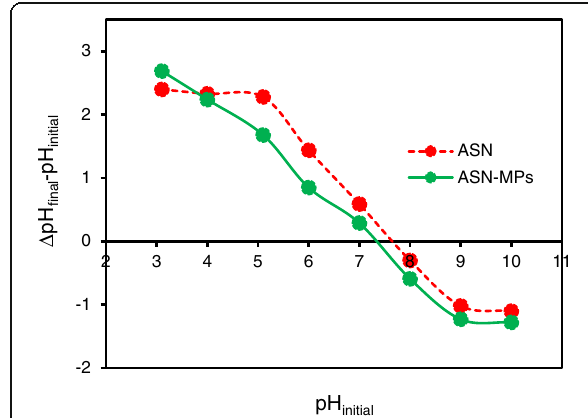
Fig. 5 Determination of the point of zero charge of the ASN